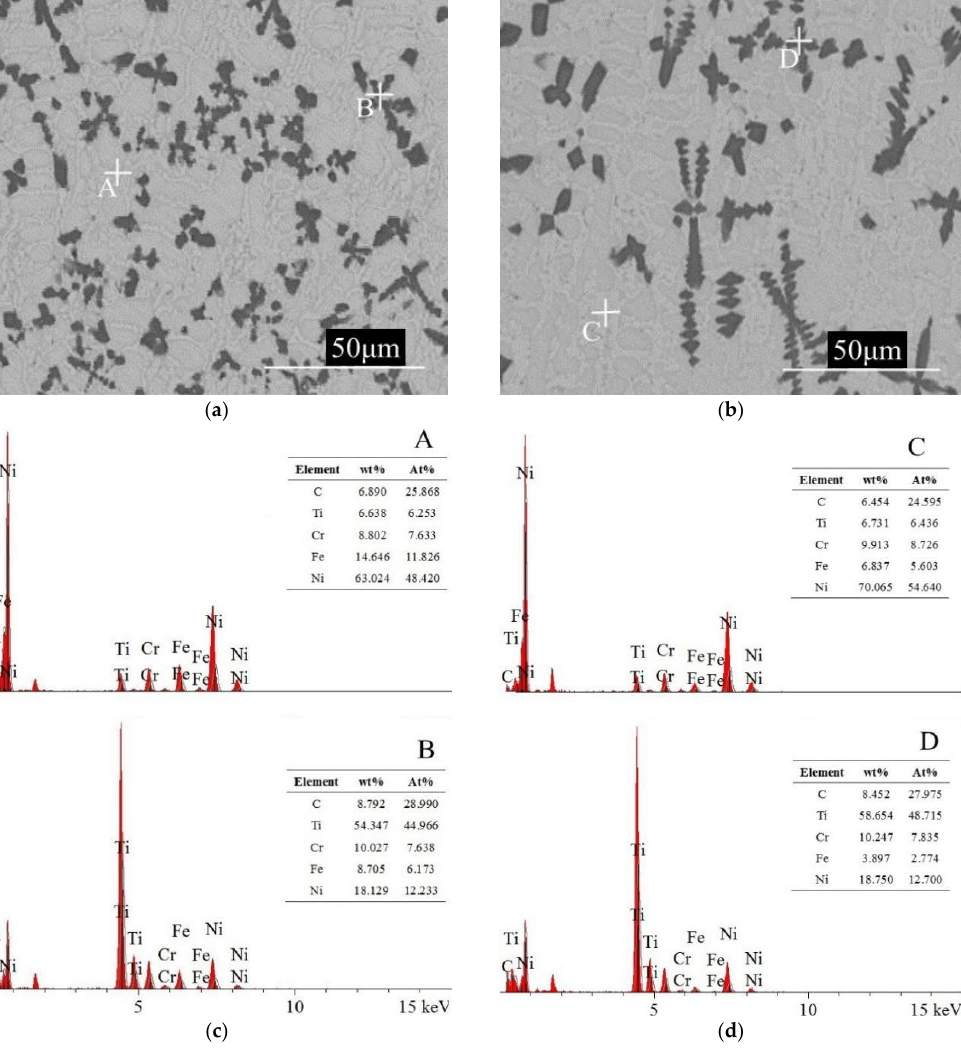
Figure 11. Structure of the cladding layer made from ( a ) 5 mm/s scanning speed. ( b ) 7 mm/s scanning speed. Element analysis of the cladding layer made from ( c ) 5 mm/s scanning speed. ( d ) 7 mm/s scanning speed. Materials 2019 , 12 , x FOR PEER REVIEW